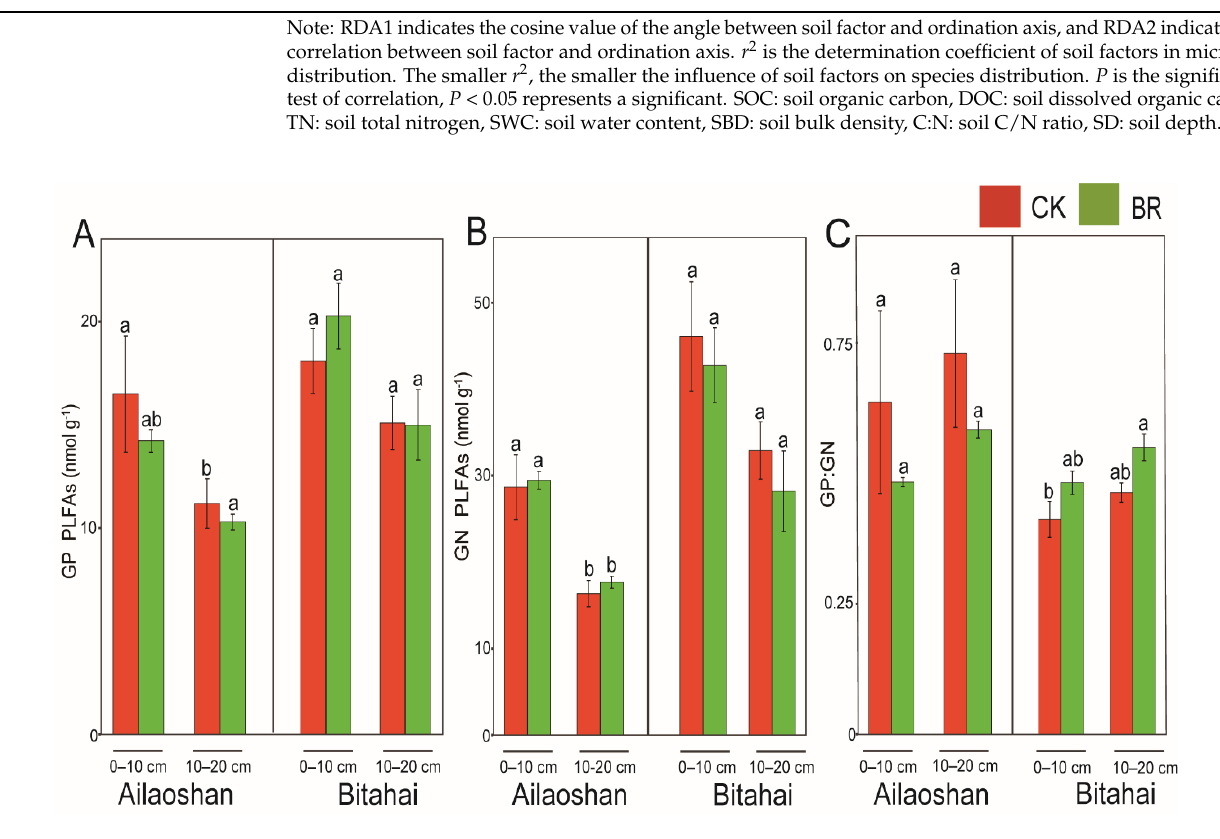
Table A2. Redundancy analysis statistics.